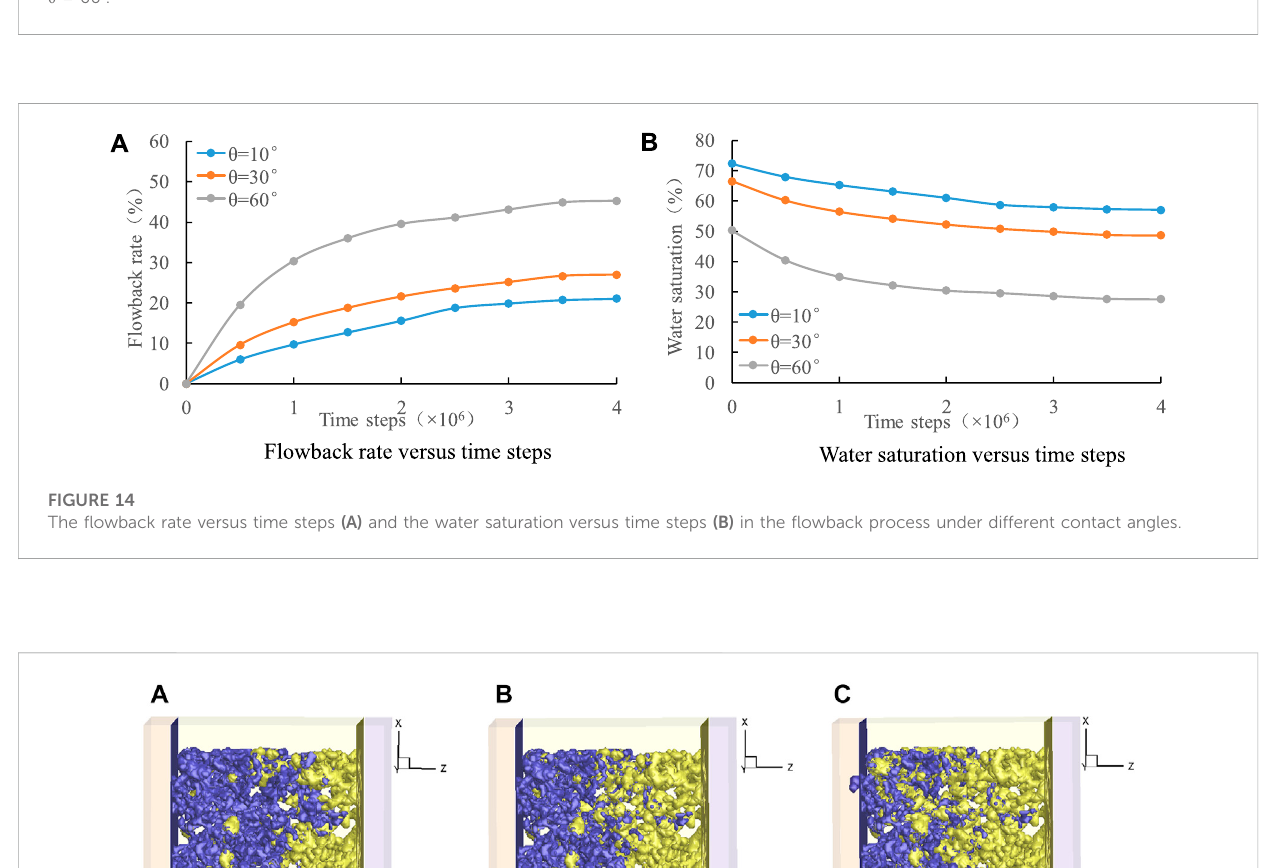
FIGURE 13 Gas-liquid distribution at the equilibrium state ( t (cid:2) 4 . 0 × 10 6 ) in the fl owback process under different contact angles. (A) θ = 10 ° , (B) θ = 30 ° , (C) θ = 60 ° .